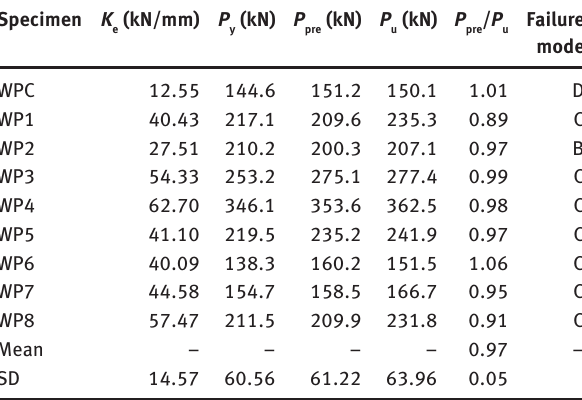
Table 5: Comparison of experimental and analytical